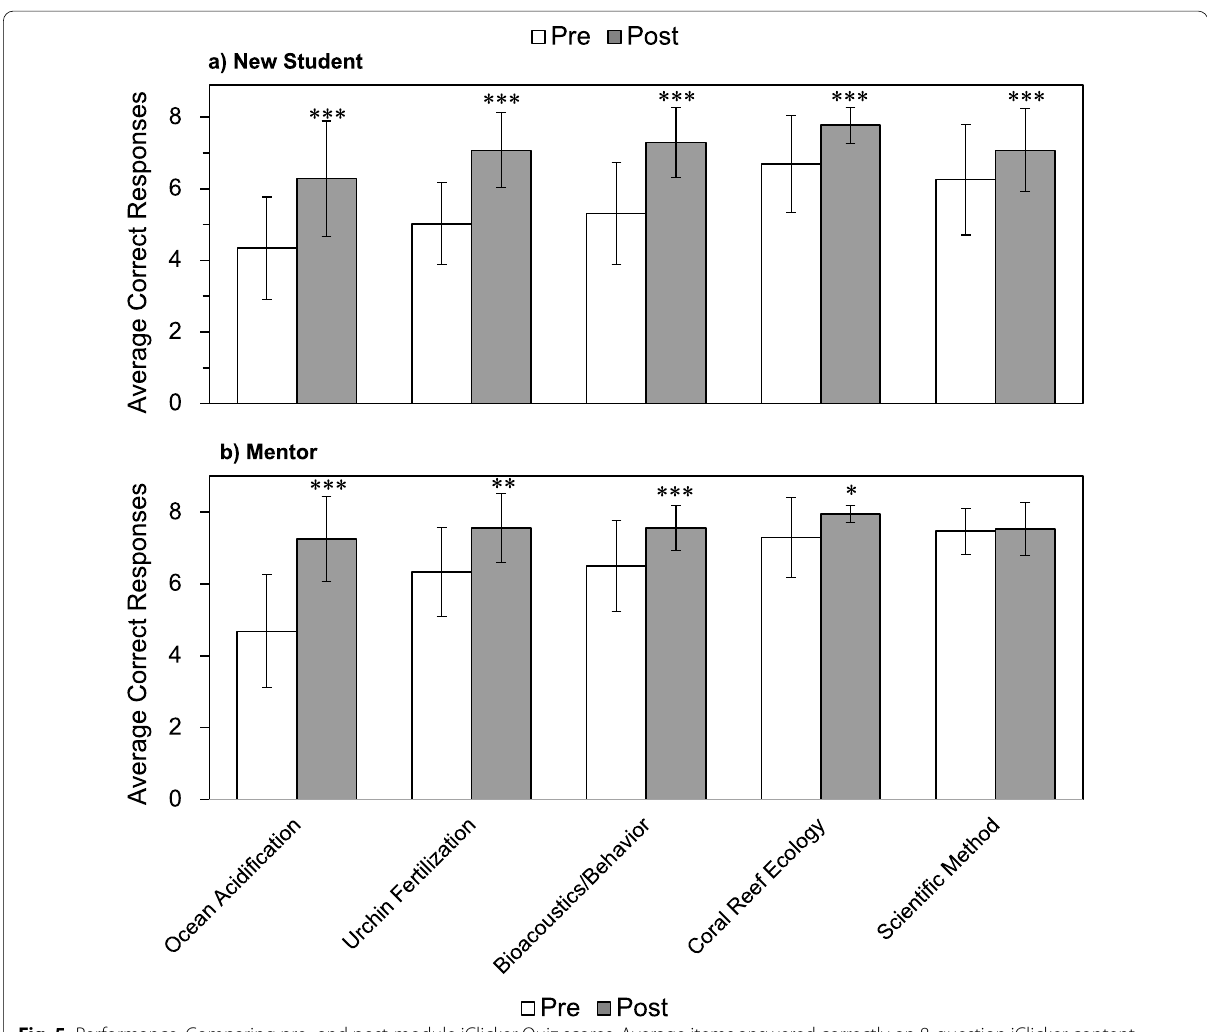
Fig. 5 Performance: Comparing pre- and post-module iClicker Quiz scores. Average items answered correctly on 8-question iClicker content quizzes, collected from a New Students ( N 54) and b) Mentors ( N 18) during the 2016–2018 REMS programs. Pre–post differences in score = = averages were compared with a paired Student’s t -test. * p < 0.05. ** p < 0.01. *** p <